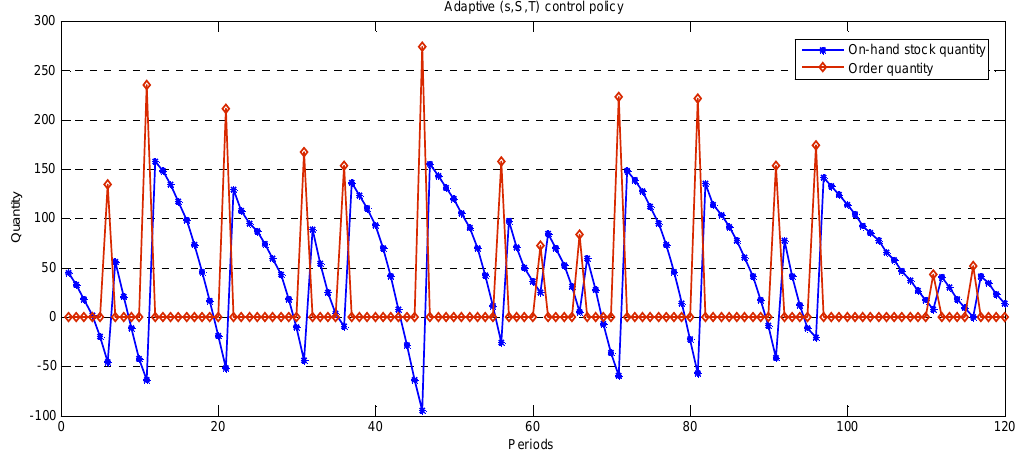
Fig.9. On-hand inventory and order curve of adaptive (s,S,T) control policy